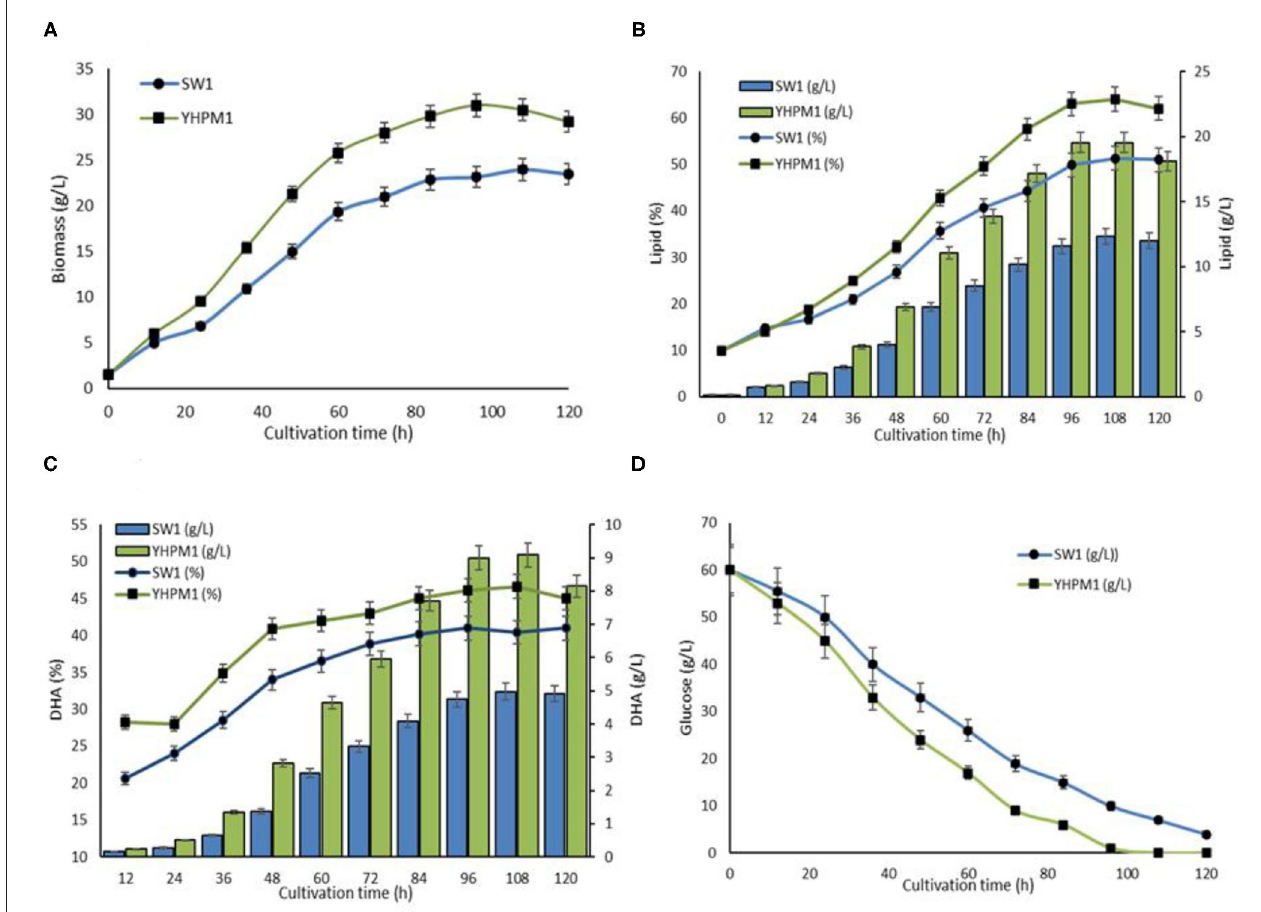
FIGURE 6 | (A) Biomass, (B) lipid, (C) DHA, and (D) glucose consumption rate of YHPM1 and SW1 cultivated in 5L bioreactor for 120h.